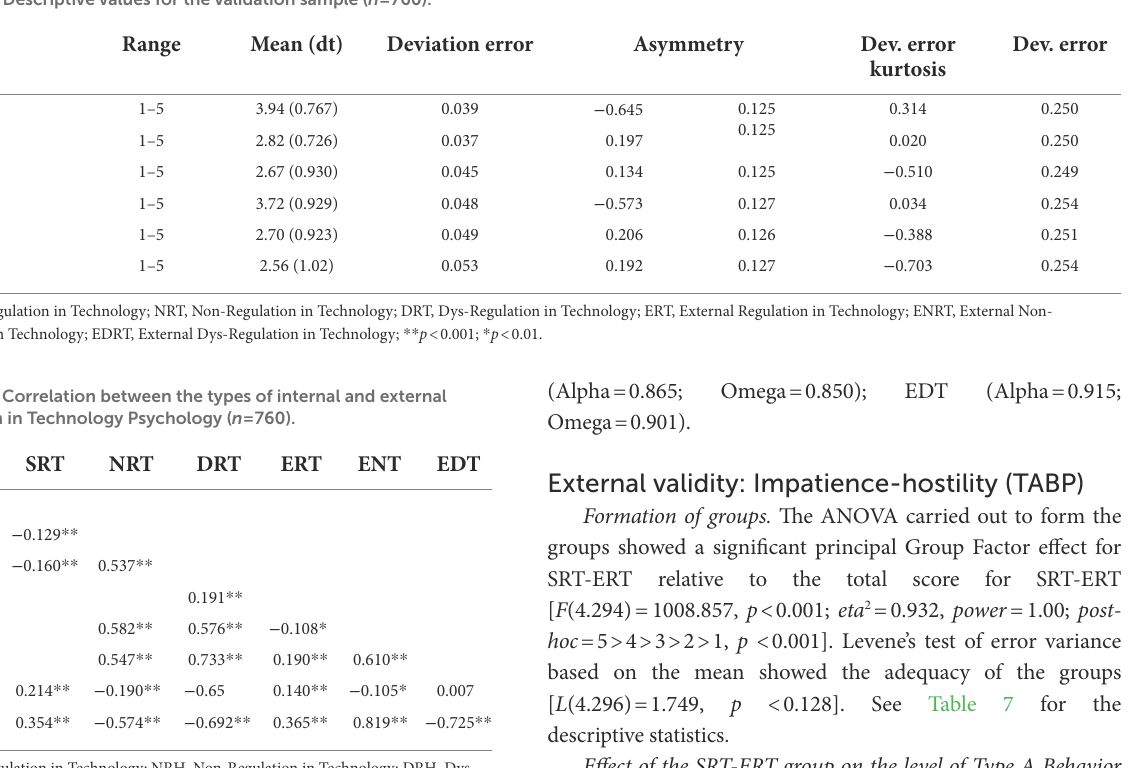
TABLE 20 Descriptive values for the validation sample ( n = 760).